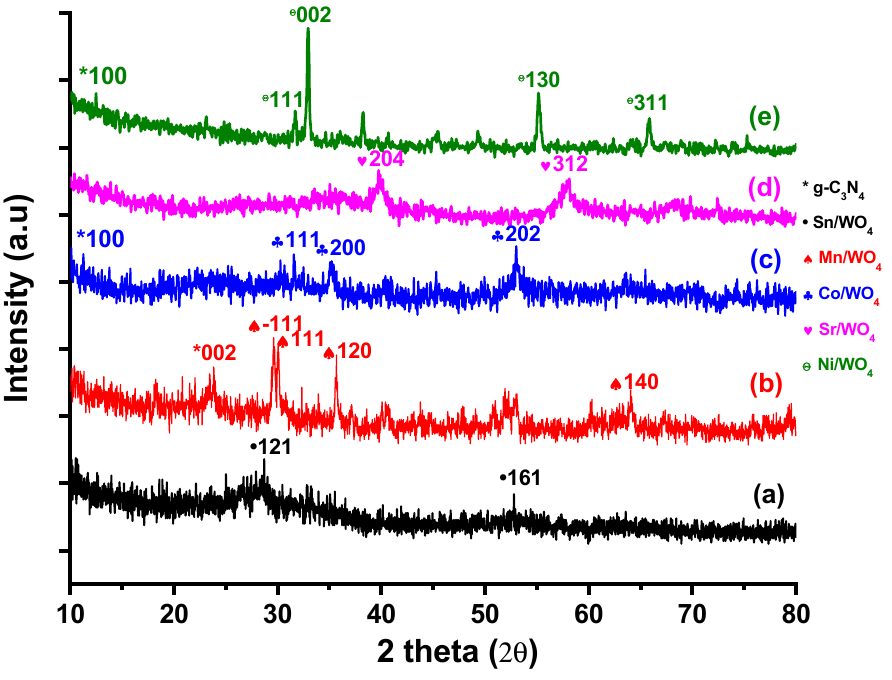
Figure 8. XRD patterns of ( a ) g-C 3 N 4 , ( b ) g-C 3 N 4 /MnWO 4 , ( c ) g-C 3 N 4 /CoWO 4 , ( d ) g-C 3 N 4 /SrWO 4 and ( e ) g-C 3 N 4 /NiWO 4 nanocomposites. Table 1. Calculated values of D avrg .